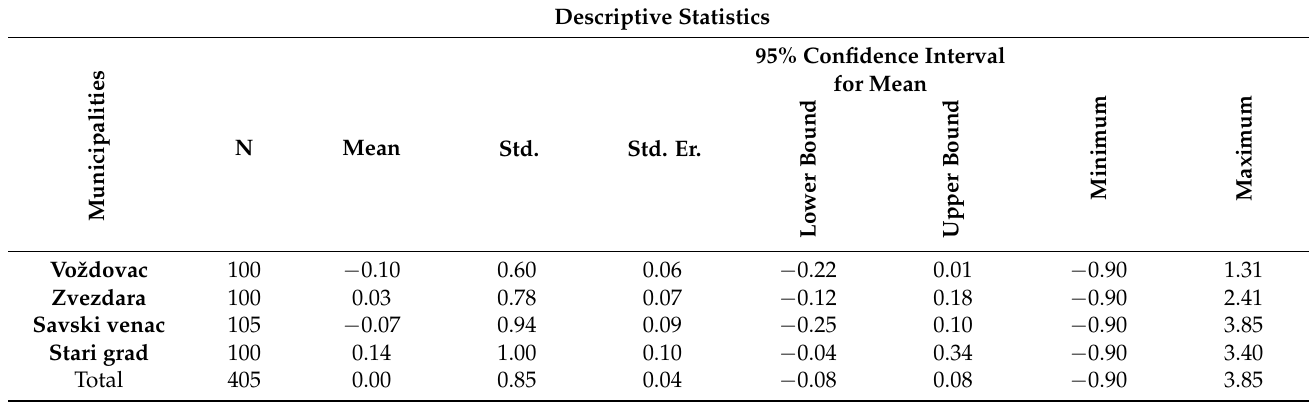
Table 5. The z score for 2 parameters (amount of money spent on medications monthly and doctor visits yearly) for all